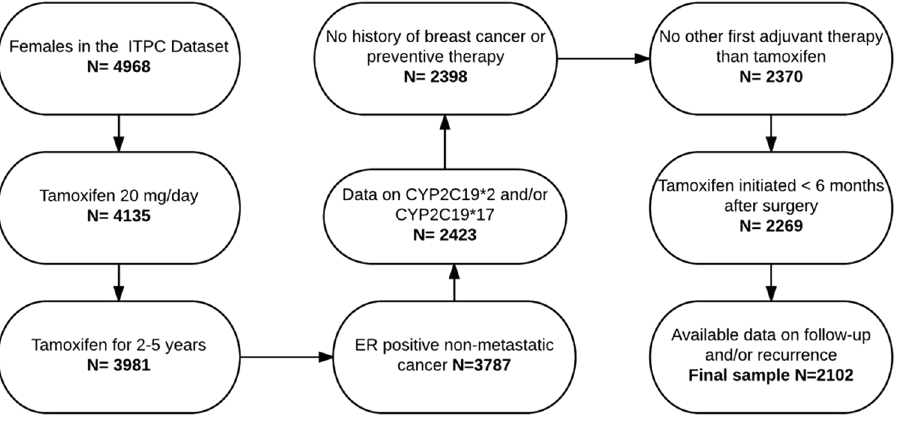
Figure 2. Study population